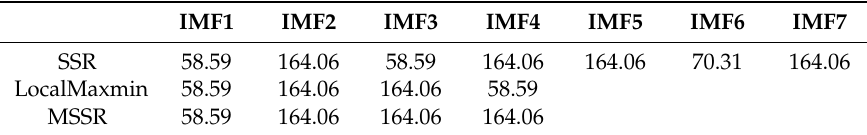
Table 3. The experimental results of inner race of motor bearing.